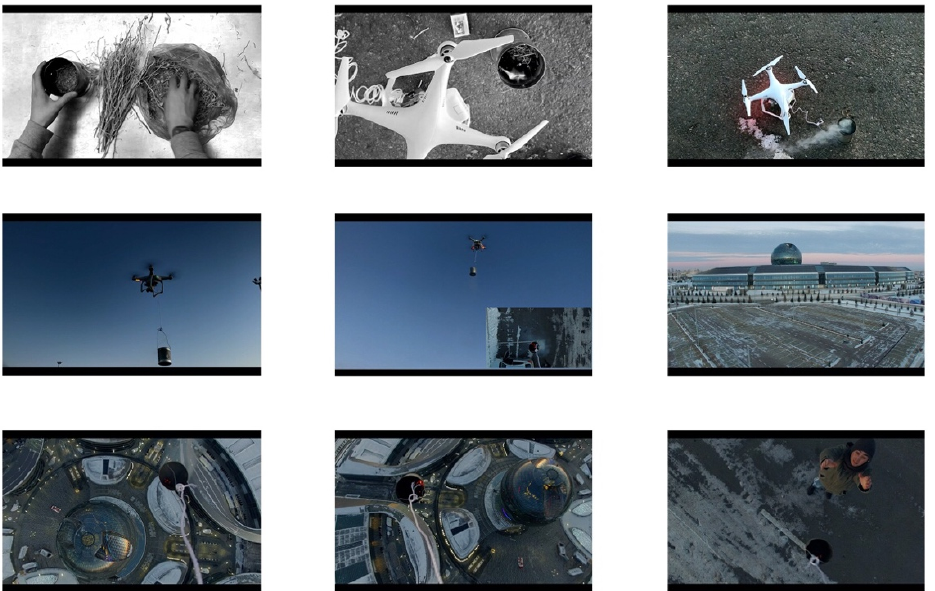
Figure 7. Anvar Musrepov, video stills of ritual performance Alastau (2017). Images courtesy of the artist and Aspan Gallery, Almaty.